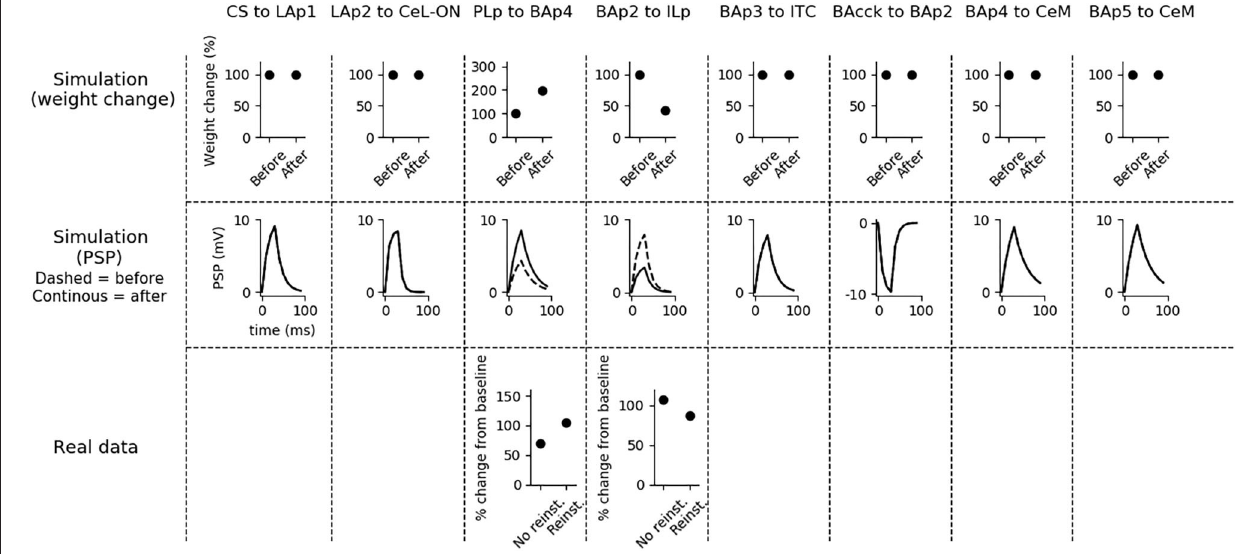
FIGURE 6 | Changes in connection weights and PSP before and after fear reinstatement. First row: simulated connection weights before and after fear reinstatement. Second row: simulated effect of a 30 ms presynaptic stimulation on the PSP of the plastic connections of the model (the presynaptic stimulation was adjusted to obtain a change of maximum 10 mV in the postsynaptic unit). Third row: real data from Vouimba and Maroun (2011) showing that, as in simulation, inputs from the mPFC to BA increase after reinstatement, while those from BA to the mPFC decrease, restoring the synaptic strength to conditioning levels. The other synapses shown here to be stable have never been reported in the literature to undergo LTP or LTD during fear